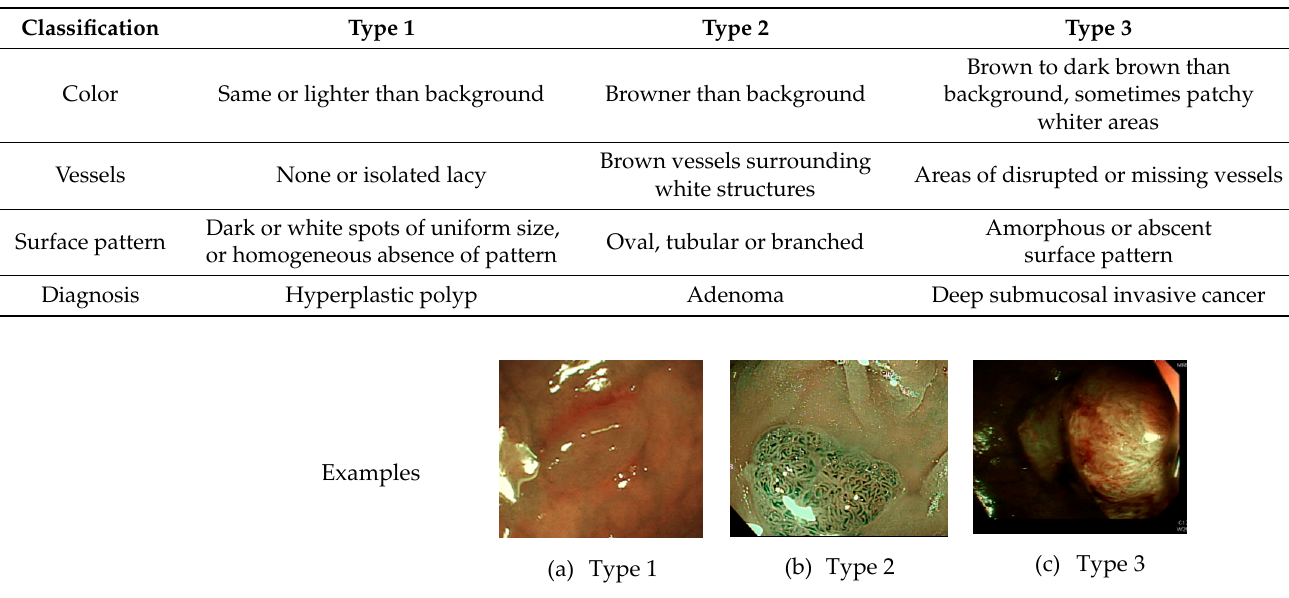
Table 1. NBI international colorectal endoscopic (NICE) classification.